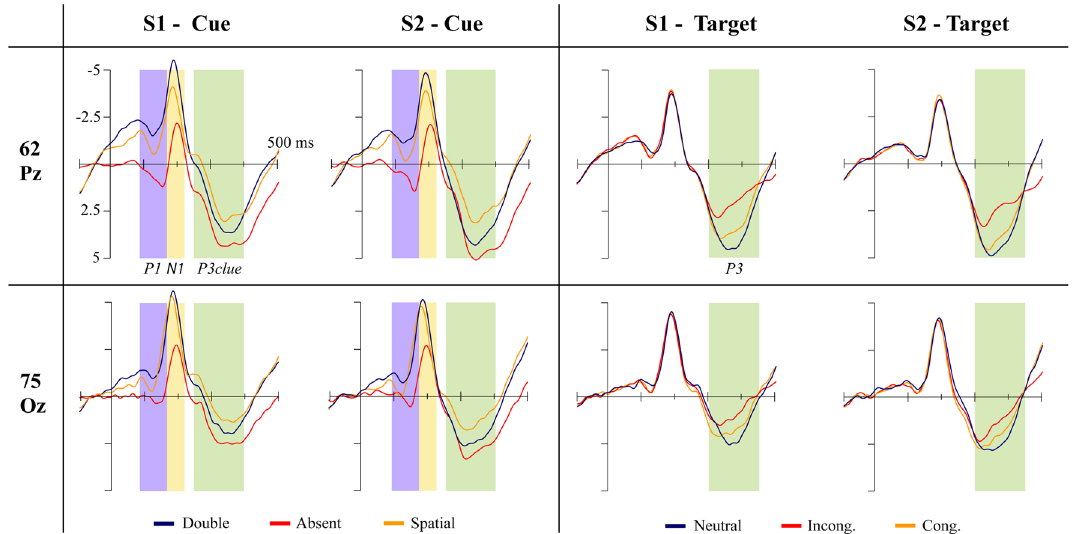
Figure 5. Averaged waveforms for cue and target conditions on Oz and Pz electrodes. It is grouped by session pre- or post-treatment, respectively S1 and S2. The figure shows each ERP time-window, denoted with colored squares (P1 = purple; N1 = yellow; P3cue = green; P3 = green).